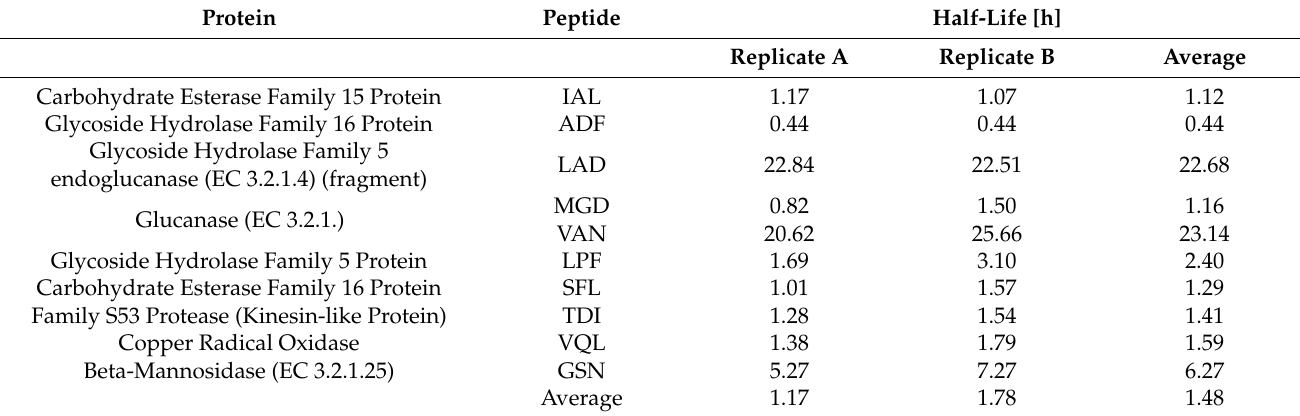
Table 3. Half-life constants of selected peptides representing the enzyme preparation used in this study. The three peptides (LAD, VAN, and GSN) were excluded from calculations of the average half-life constants as their values significantly exceeded the range of the other